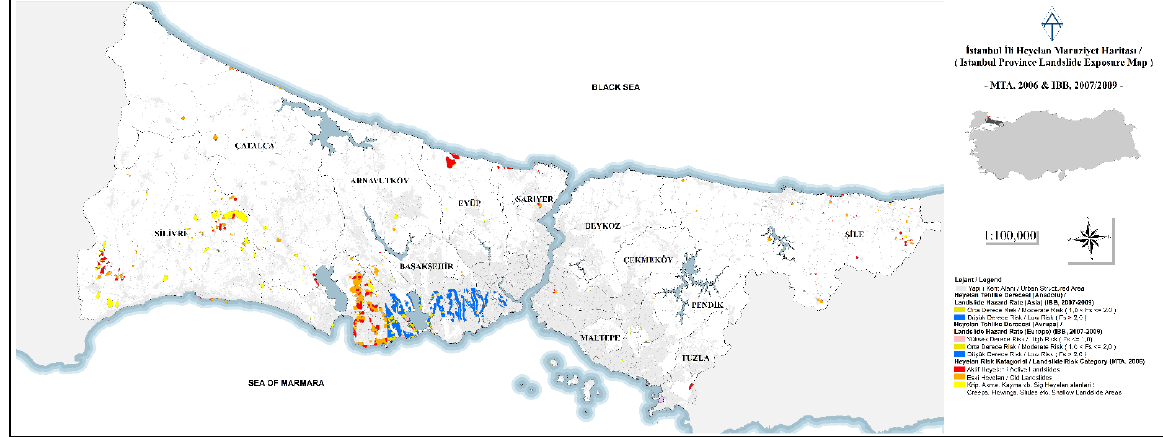
Figure 9. Istanbul Province Landslide Exposure Map (MTA, 2006 & IMM, 2007/2009).